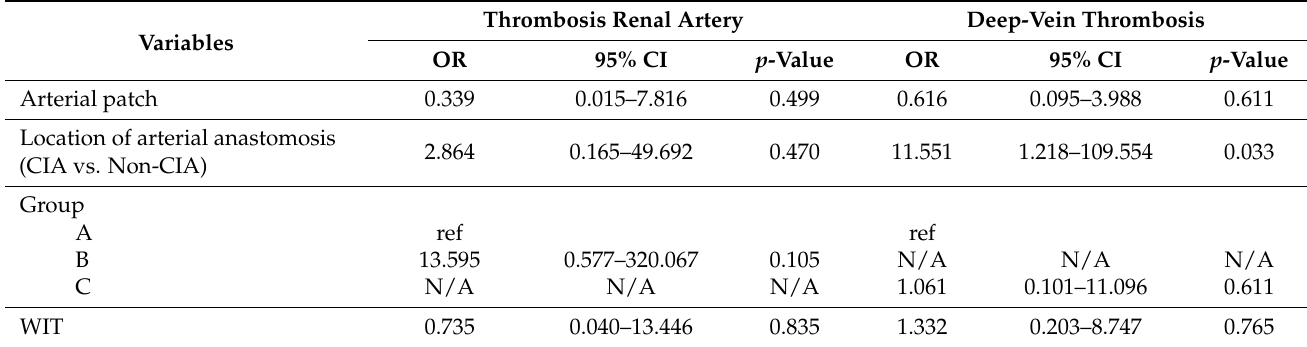
Table 4. Multivariate analysis of kidney transplant outcome